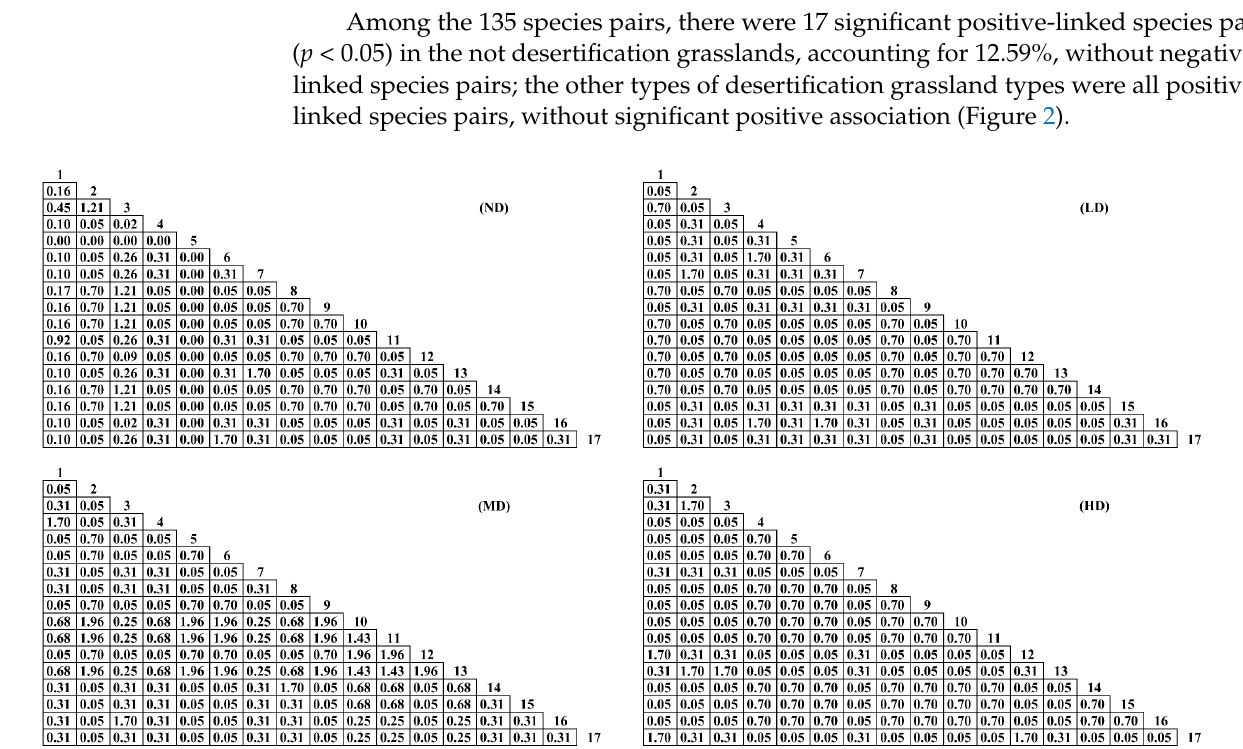
Figure 2. Chi-square test of p -value matrix of main species in different desertification stages in Qinghai Lake basin. This graph represents the significance level of the chi-square test for different plant species. ND stands for not desertification, LD for light desertification, MD for moderate desertification, HD for heavy desertification. See Table 1 for the meanings of species numbers.